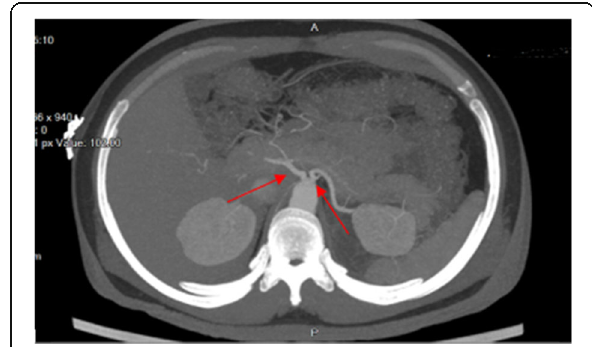
Fig. 2 Abdominal CT scan axial image showing the separate origin of the common hepatic artery and splenic artery from the aorta